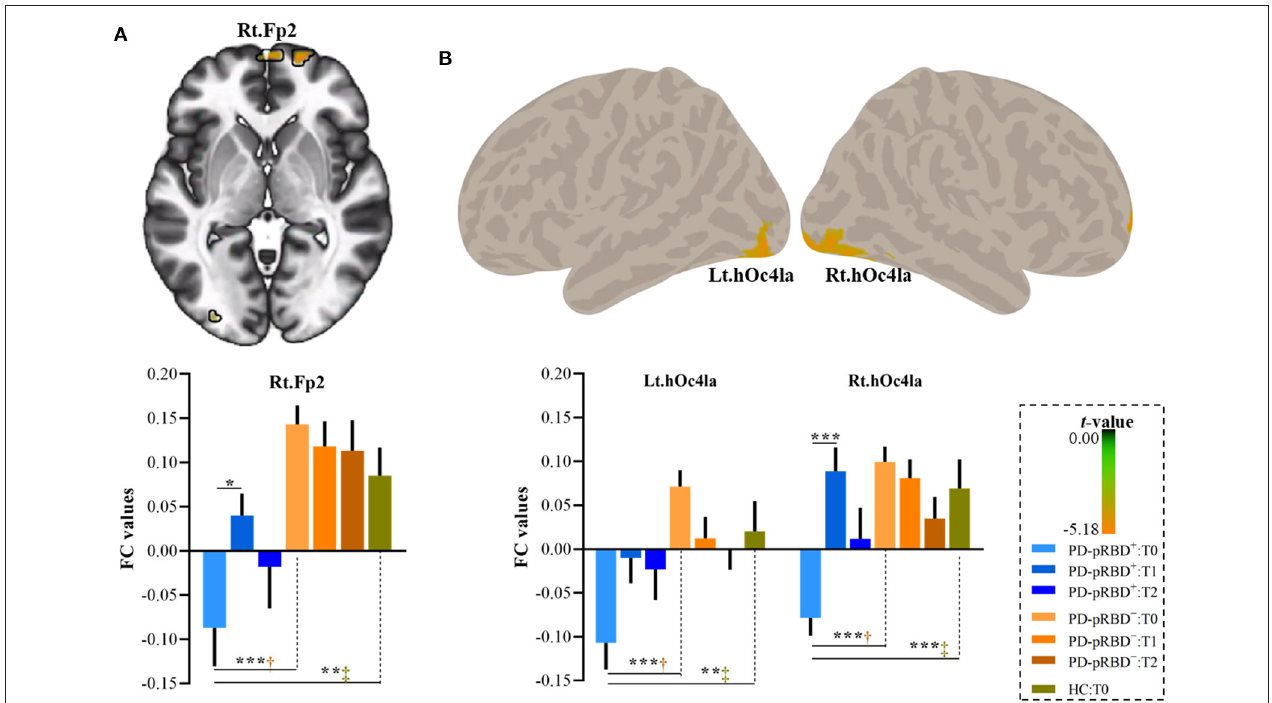
FIGURE 4 | Decreased FC in the DLPFC in PD-pRBD + compared to PD-pRBD − at baseline fMRI scans. (A) Decreased FC in the right Fp2; (B) Decreased FC in the bilateral hOc4la. Bar graph showed the mean extracted FC values in these regions. The results were thresholded based on an uncorrected voxelwise height threshold of p < 0.001 combined with an FWE-corrected clusterwise threshold of p < 0.05. Mixed repeated measures analysis of variance was performed to compare the longitudinal changes between PD groups with visit-time (i.e., T0, T1, T2) as within-group factor and group (i.e., PD-pRBD + and PD-pRBD − ) as between-group factor. Post-hoc comparisons were further performed to determine longitudinal changes over time within group and differences between groups at each visit time. Abbreviations: hOc41a, the anterior third of the middle and inferior lateral occipital gyri; Fp2, medial frontopolar area 2; T0, fMRI data at onset; T1, the 1-year follow-up evaluation; T2, the 3-year follow-up evaluation. PD-pRBD + , Parkinson’s disease (PD) with probable rapid eye movement (REM) sleep behavior disorder (pRBD); PD-pRBD − , PD without pRBD; HC, healthy control. Lt, left; Rt, right. † showed significant differences between patients with PD-pRBD + and PD-pRBD − ; ‡ showed significant differences between patients with PD-pRBD + and HCs. * p < 0.05 with Bonferroni correction; ** p < 0.005 with Bonferroni correction; *** p < 0.001 with Bonferroni